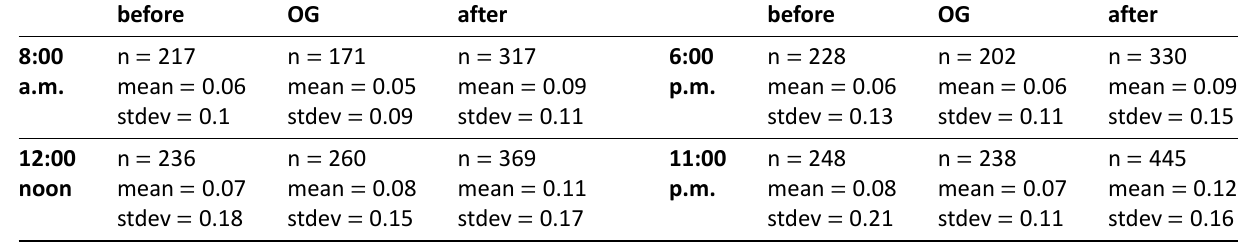
Table 2. Values for the hot spot analysis using KDE for visitors’ negative tweets for specific hours.